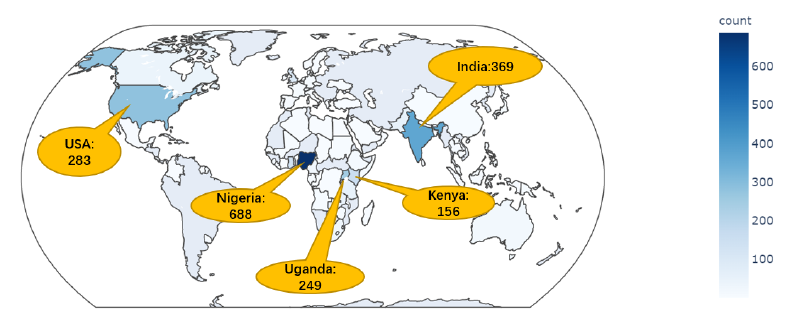
Figure 7. The location of tweets related to